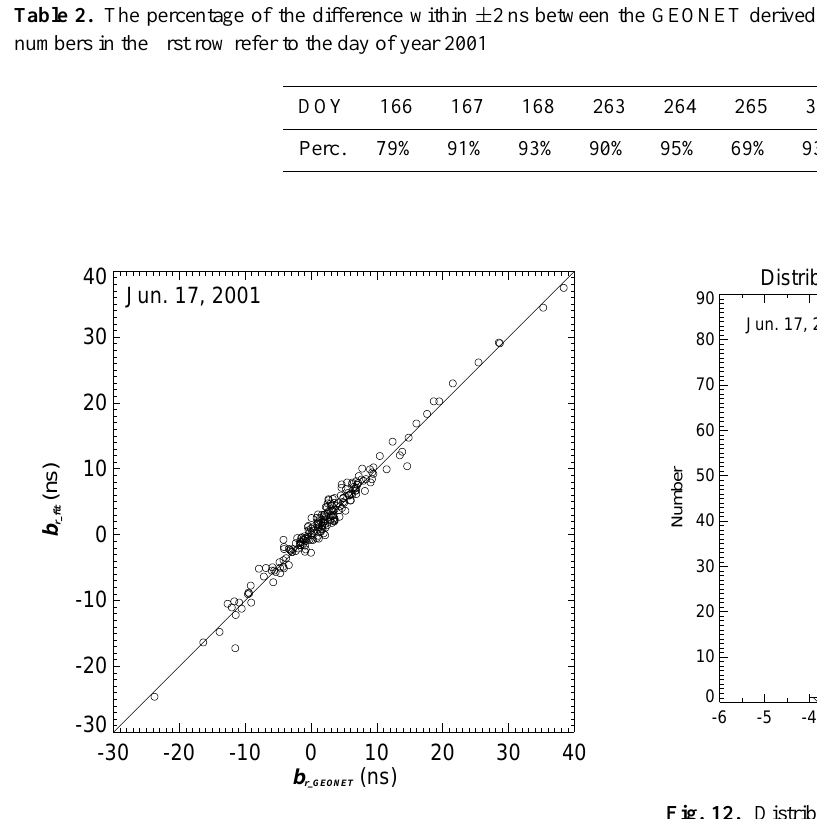
Fig. 11. Singly fitted bias is plotted versus GEONET derived bias for all receivers on 17 June 2001. The relationship b r GEONET = b r fit is also shown for comparison.